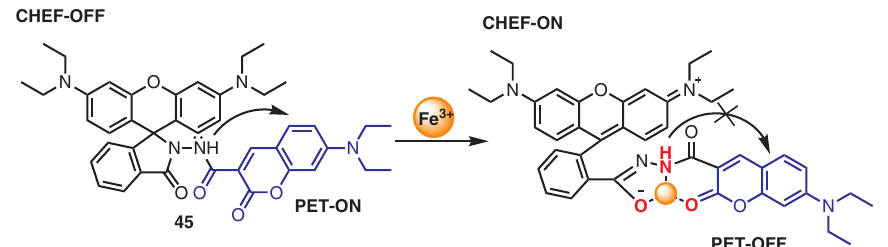
Figure 29: Proposed complex mechanism of 45 -Fe 3 + .